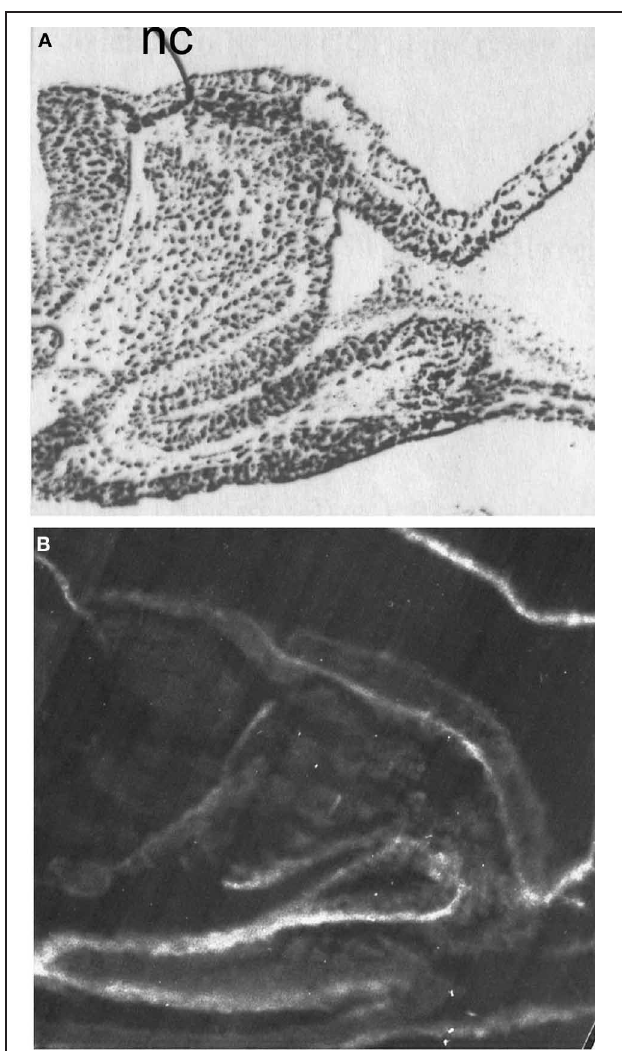
FIGURE 9 | Distribution of AChE activity (A) and fibronectin-like molecules (B). AChE activity is revealed by dark staining, (Karnovsky and Roots, 1964); Fibronectin is revealed by immunofluorescent reaction. Resin sections, 5 μ m; nc, neural crest. Bar equals 100 μ m.